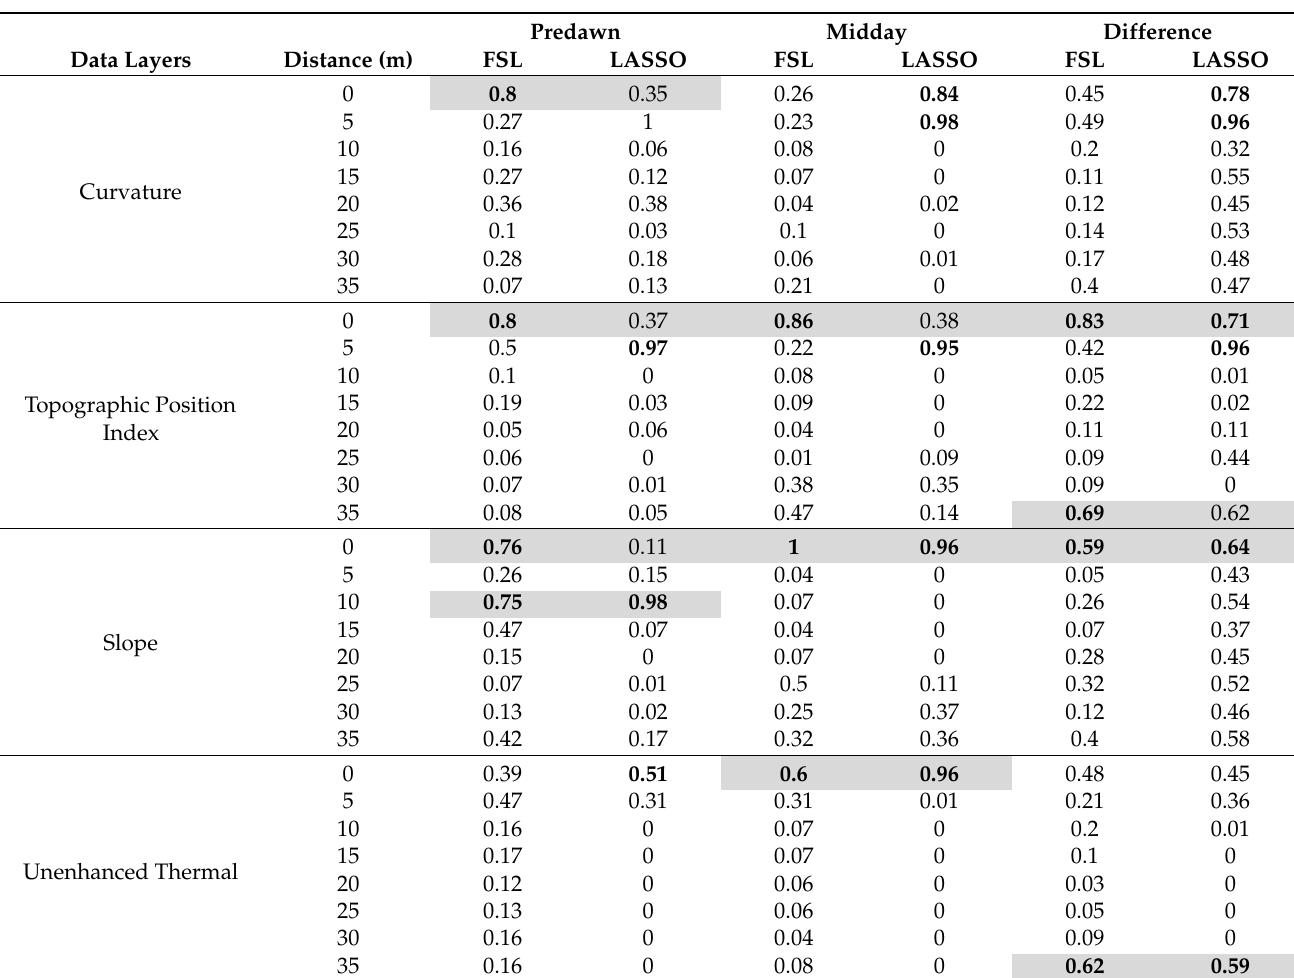
Table 1. Summary of covariates and percentages in which each covariate was selected based upon 100 model iterations for forward stepwise logistic (FSL) and Least Absolute Shrinkage and Selection Operator (LASSO) regression analyses for terrain analysis indices (Curvature, Topographic Position Index, and Slope) and the Unenhanced Thermal imagery for the three imagery types (Predawn, Midday, and Difference). Distance is in meters from the center of known cave entrances. Values in the corresponding cells represent the percentage of iterations in which each covariate was selected. Bold values denote covariates selected more than 50% of the iterations and greyed cells indicate the covariates selected for the final